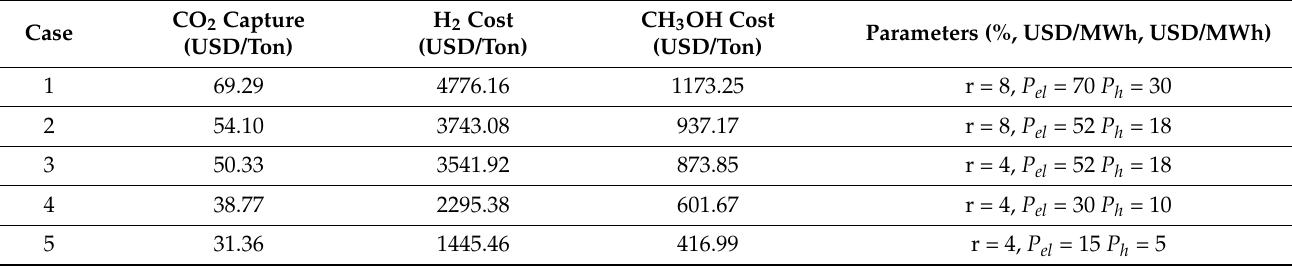
Table 6. Model outputs for different discount rates, as well as electricity and heat